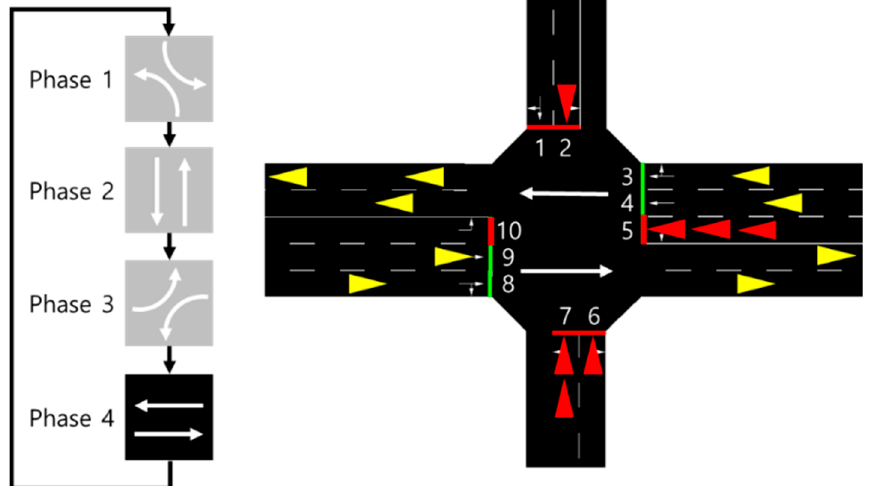
Figure 2. Example of traffic signal control at a single intersection.